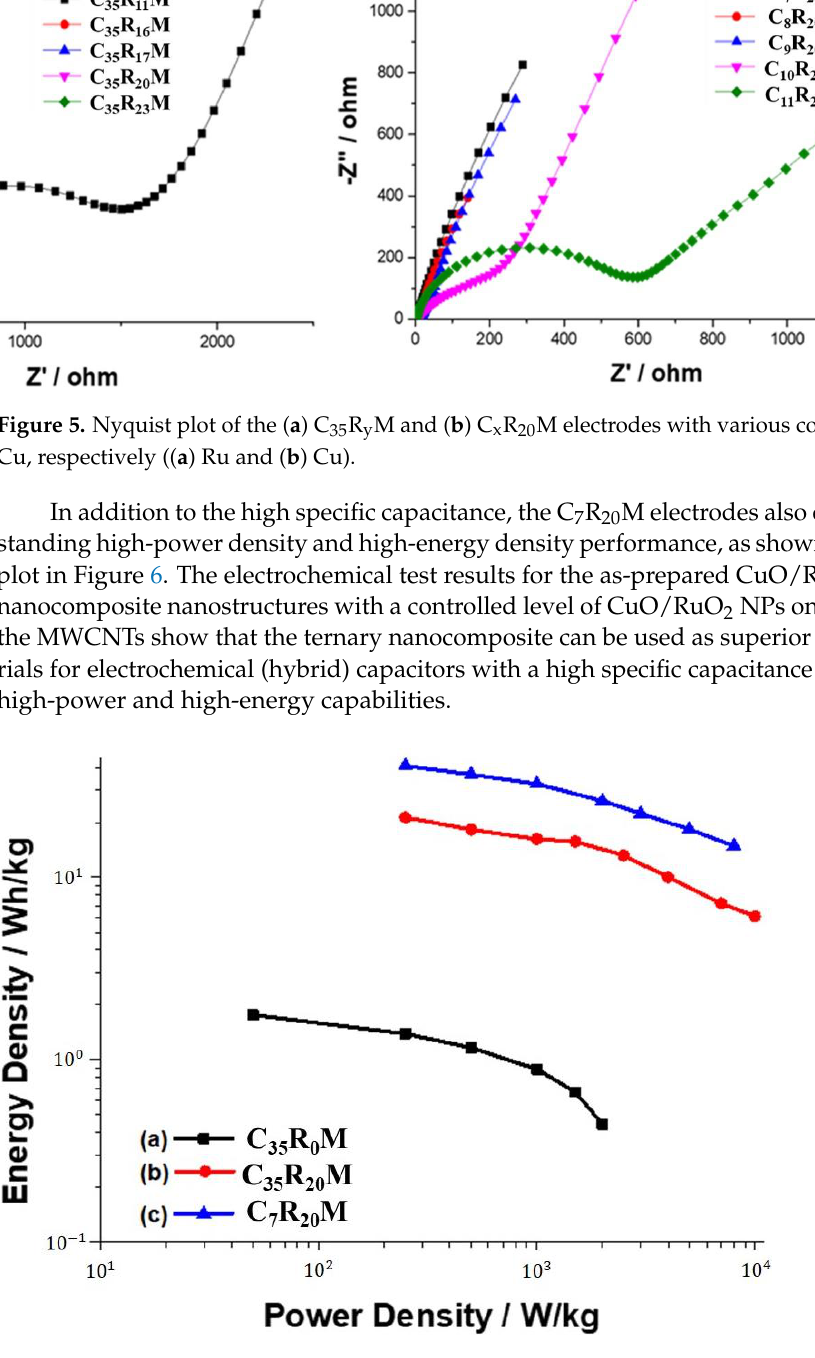
Figure 6. Ragone plot of (a) C 35 R 0 M (b) C 35 R 20 M and (c) C 7 R 20 M